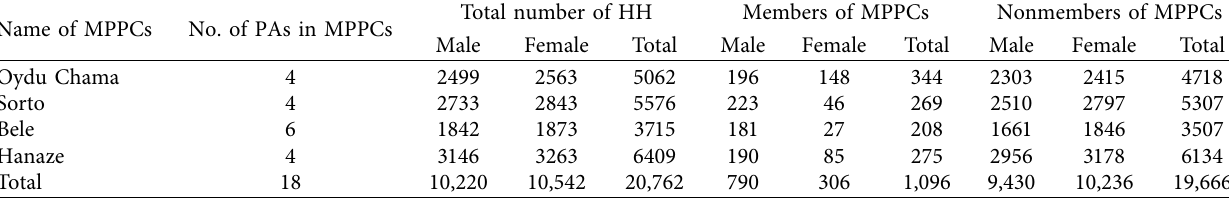
Table 1: Multipurpose primary cooperatives and their member and nonmember households in the study district Name of MPPCs